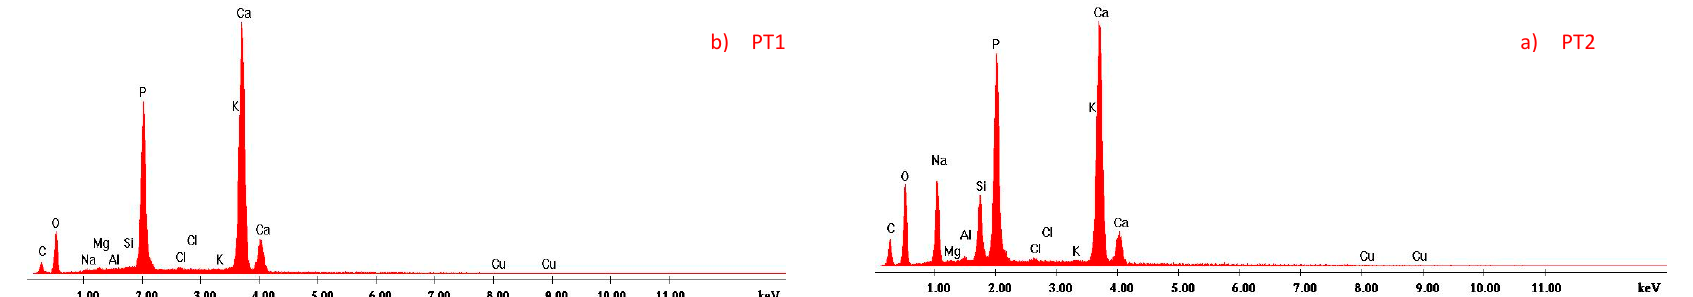
Figure 46. BSE images of light blue glass tessera opacified with Ca-phosphate (KH_G10 light blue natron-based Egypt I glass tessera from Khirbet al-Mafjar, Palestine [23]). Note the non-homogeneous micro-texture of the vitreous matrix, dotted with gas bubbles ( a ) and the presence of millimetric inclusions unevenly dispersed inside it, either with reaction rims ( b , c ) or compact ( d ).